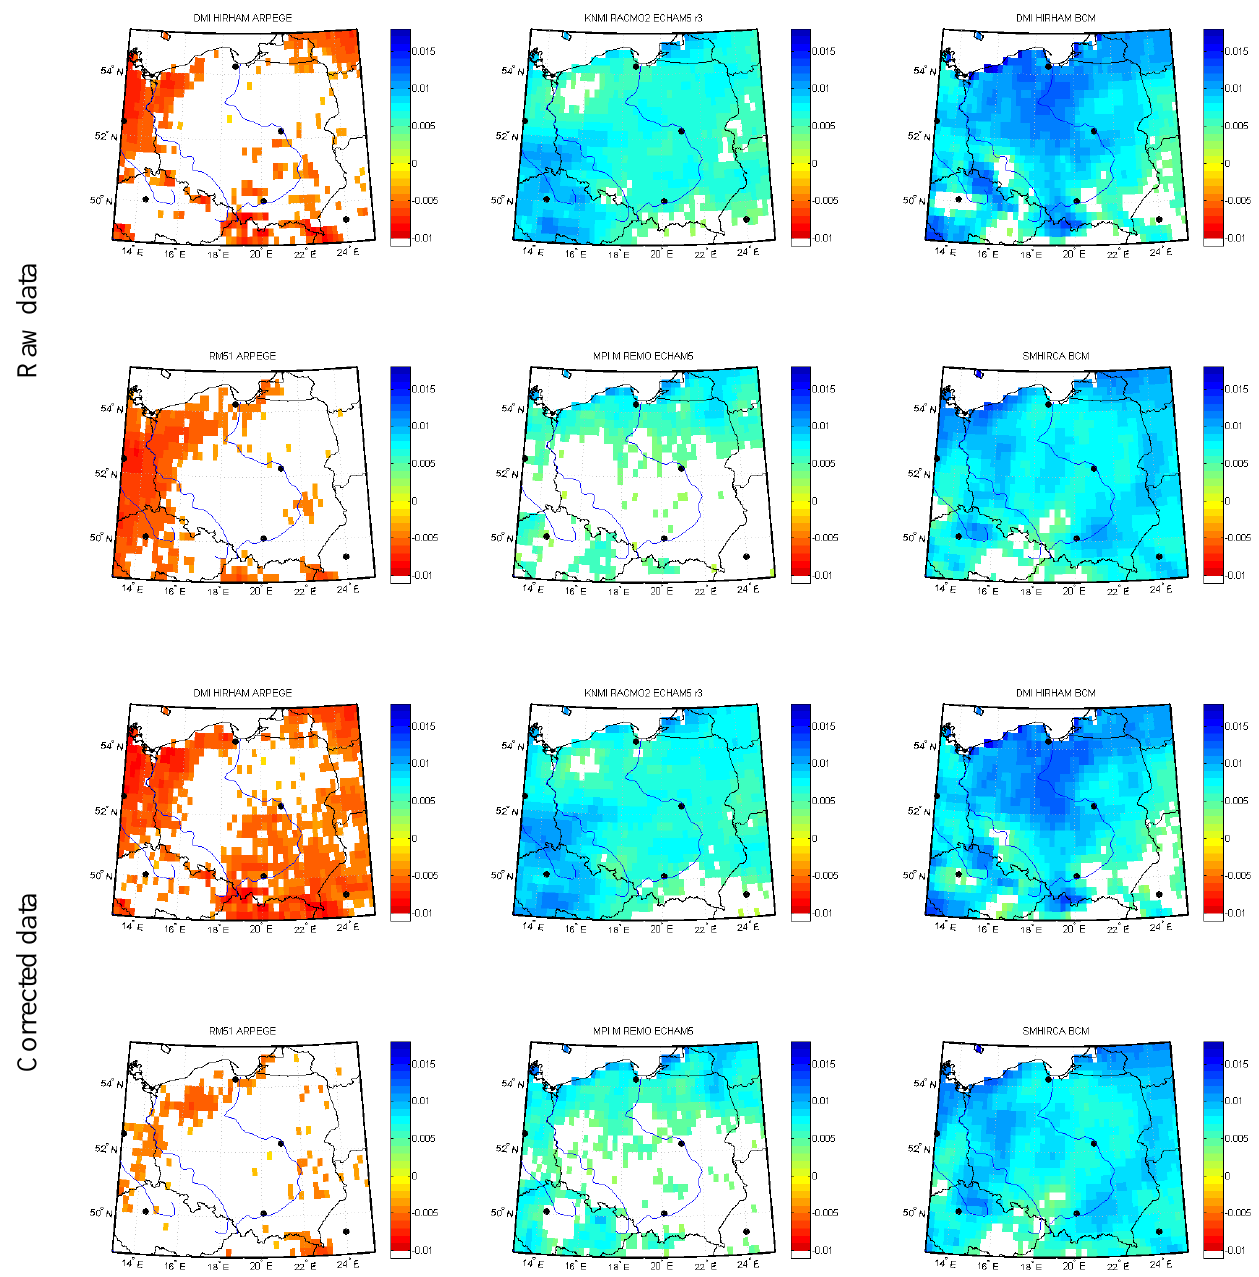
Figure 13. Trends in the SPI 12. Colour scale denotes the slope of the estimated linear trend. White areas indicate the lack of statistically significant